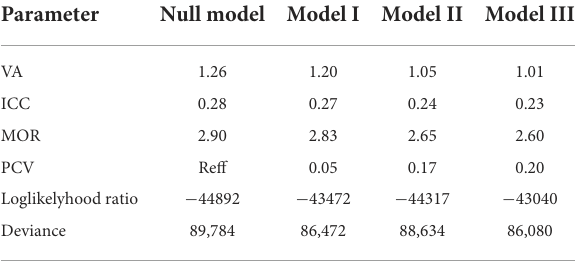
TABLE 3 Random effect analysis result and model